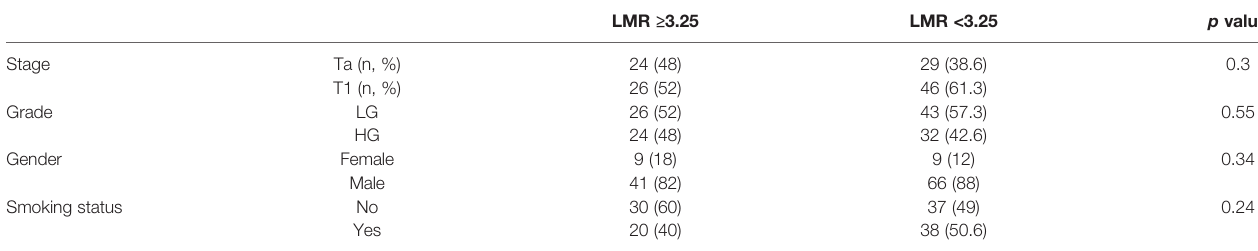
TABLE 3 | Clinical parameters in patients divided by LMR cut-off